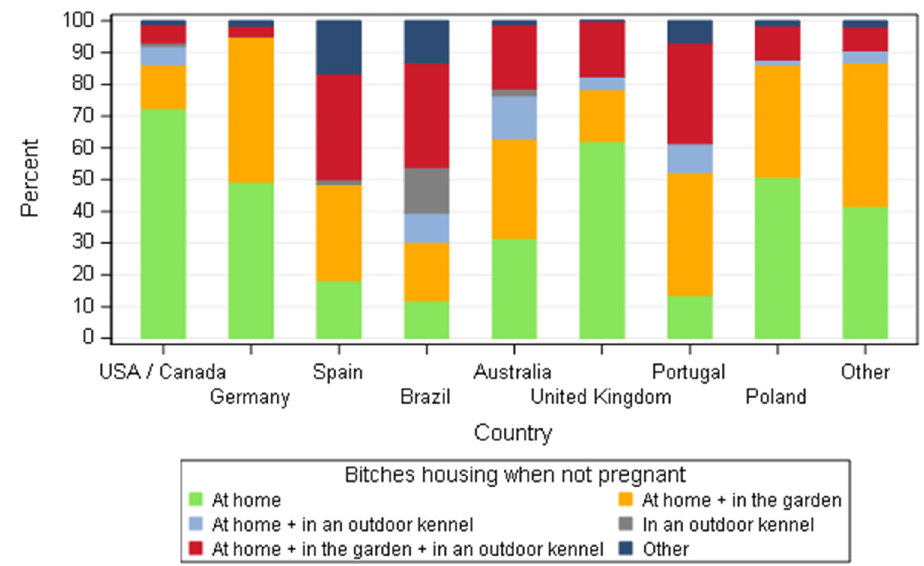
Figure 4. Housing system distribution for non-pregnant bitches according to dog breeders by country—all responders ( n = 668).